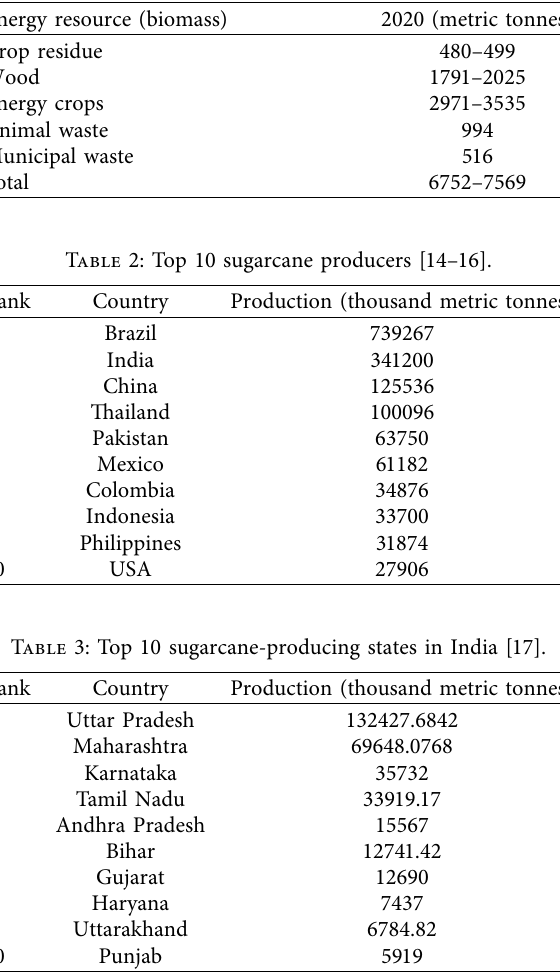
Table 1: World’s biomass potential [8].